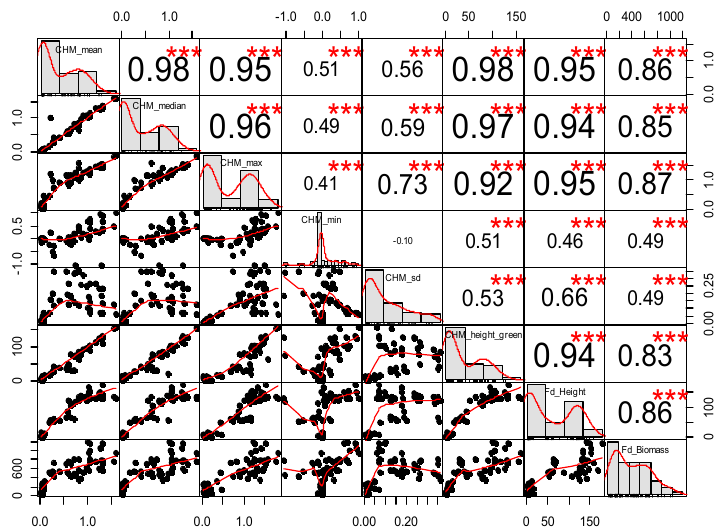
Figure 7. The correlation coefficient charts between canopy height model (CHM) metrics and field measurement for all three study sites. The diagonal line in the figure shows the distributions of the variables themselves. The lower triangle (left and the bottom of the diagonal) in the figure shows scatter plots of the two properties. The upper triangle (upper right of the diagonal) in the figure indicates the correlation values of the two attributes; the asterisk indicates the degree of significance (more stars indicate greater significance, *** = p -value of <0.001.). The bold bigger numbers mean the higher correlation.